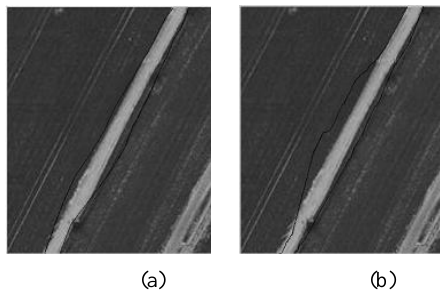
Figure 11: (a) Ziplock Snake with (15x15) Gaussian Kernel Filter (b) Ziplock Snake with (10x10) Gaussian Kernel Filter